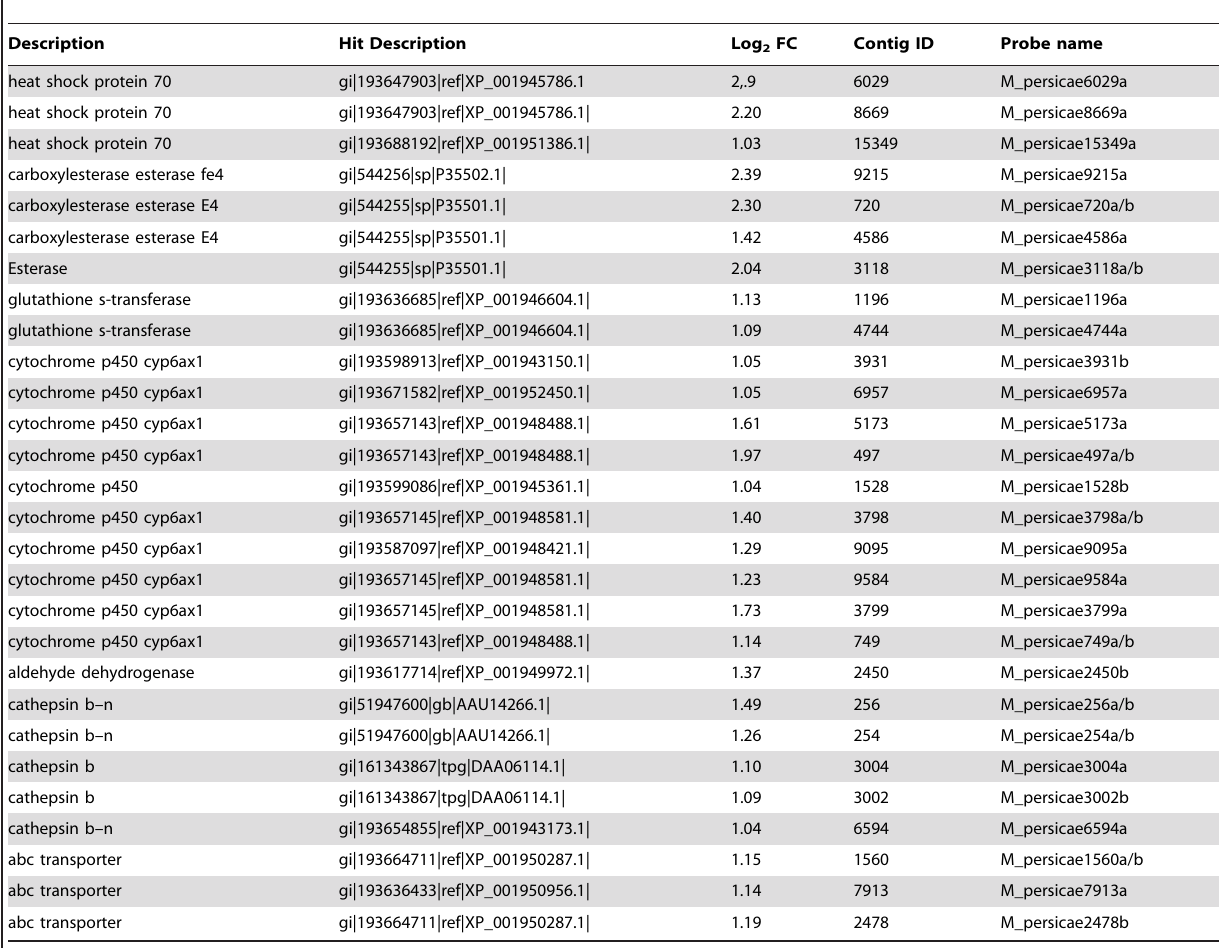
Table 2. Selected genes identified by microarray as significantly up-regulated in S (sensitive) genotype in response to pirimicarb.